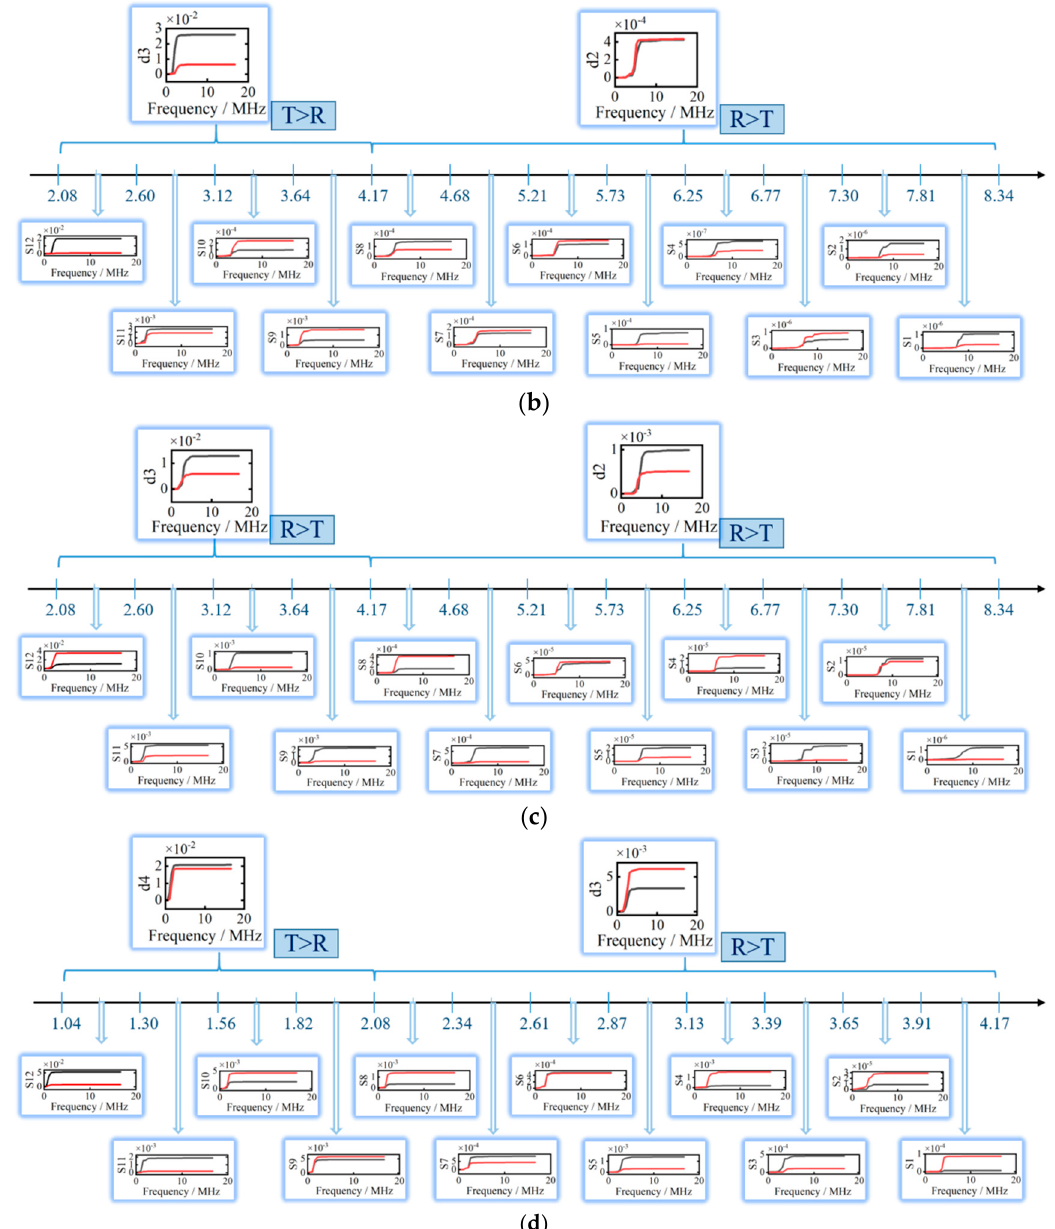
Figure 15. The decomposed frequencies distribution for crack. ( a ) At crack with depth of 0.2 mm. ( b ) At crack with depth of 0.3 mm. ( c ) At crack with depth of 0.4 mm. ( d ) At crack with depth of 0.5 mm.